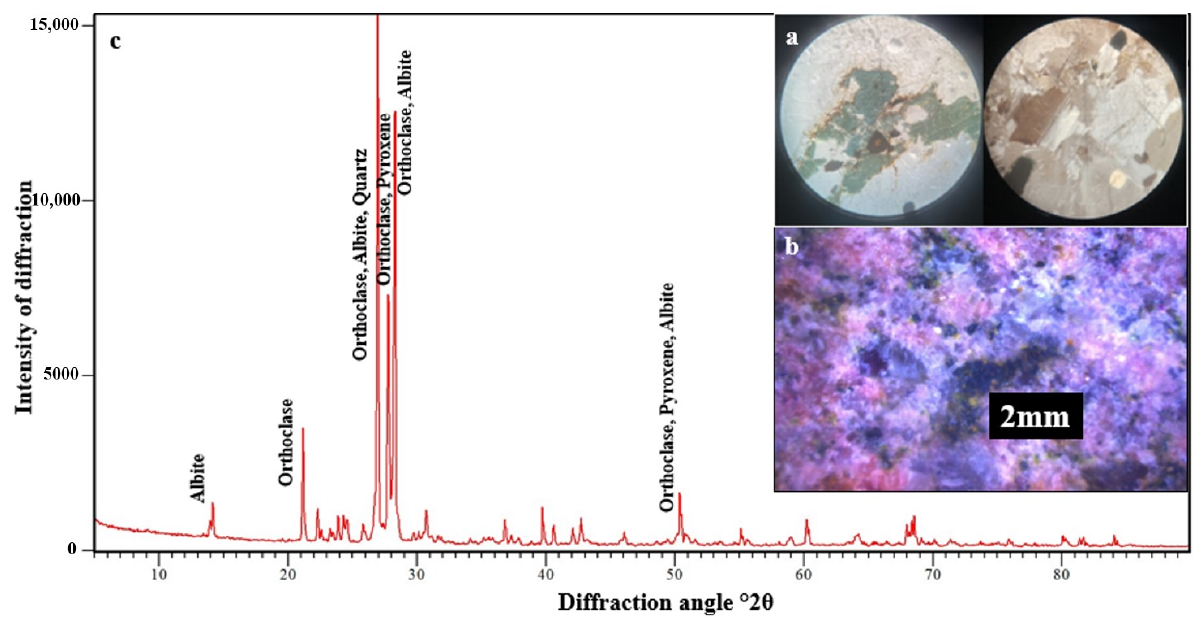
Figure 11. ( a ) Petrographic thin section; ( b ) SEM micrograph, and ( c ) XRD of gneissic rock sample from the study area.